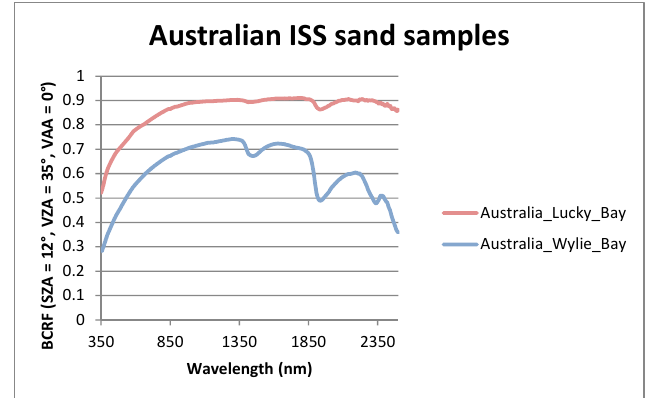
Figure 10. Spectral variation of BCRF for the Australian Internal Soil Standard (ISS) samples.